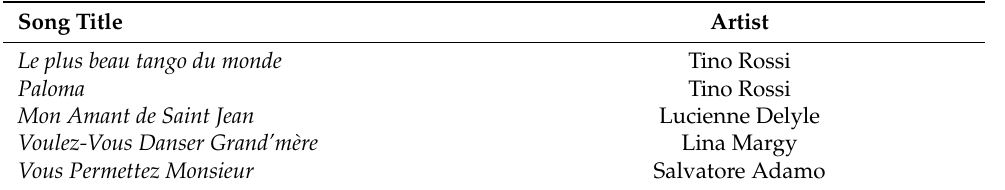
Table 2. Songs frequently